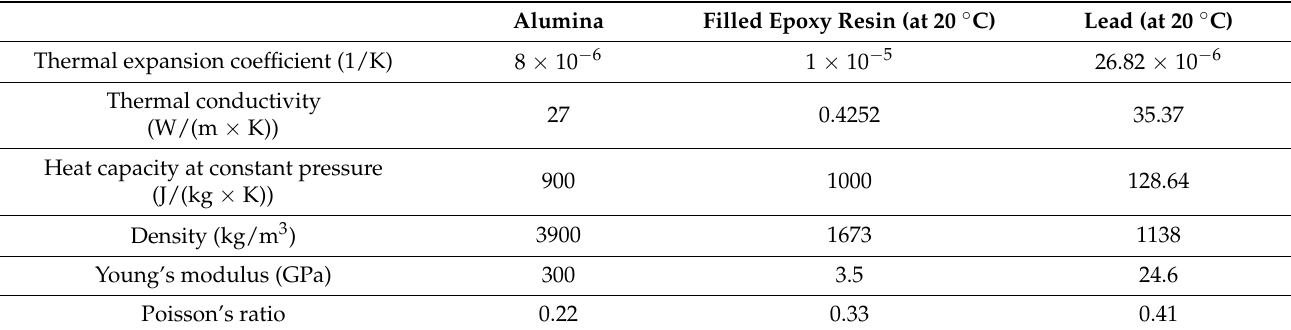
Table 1. Material properties of heat transfer model components.